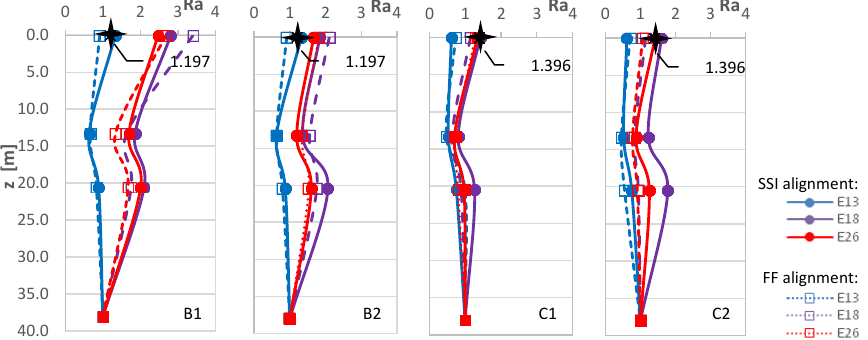
Figure 12. Comparison between amplification ratios in SSI and FF alignments for the eight models studied in the visco-nonlinear analyses.